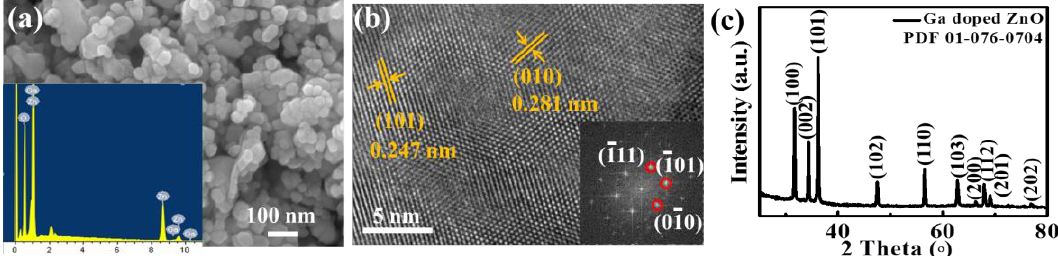
Figure 3. Characterization of n-type Ga-doped ZnO sensing material: ( a ) SEM and energy dispersive spectrum (EDS) (inset); ( b ) HRTEM and fast Fourier transmission (FFT) (inset); ( c ) XRD pattern.